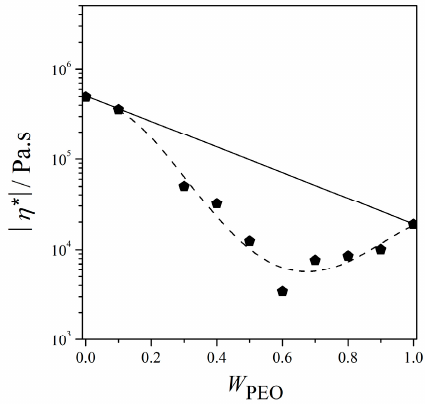
Figure 6. Viscosity evaluated at f = 0.01 Hz as a function of mass fraction of PEO at T = 140 °C. The solid curve represents the additive curve as in Equation (7). The dashed curve is the 4th polynomial regression curve with R 2 > 0.95 for visual inspection ( cf. text).